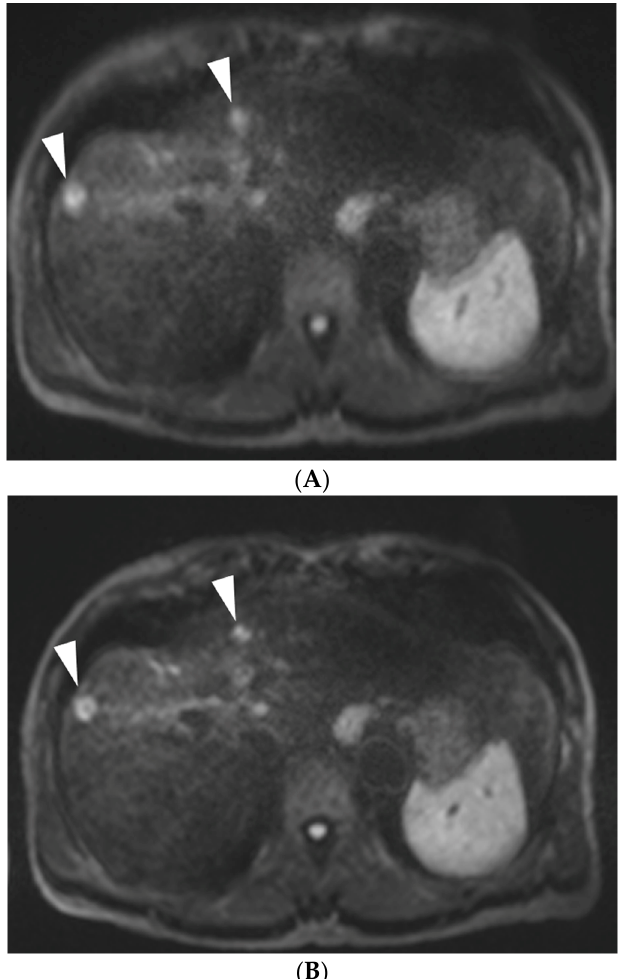
Figure 4. A 57-year-old man with hepatocellular carcinomas who underwent DWI. ( A ) Axial c-DWI (b = 800 s/mm 2 ) and ( B ) axial moco-DWI ((b = 800 s/mm 2 ). The conspicuity of the two hepatocellular carcinoma nodules (arrowheads) is better in moco-DWI ( B ) than in c-DWI ( A ). Table 3. Comparison of ADC measurement in liver parenchyma between c-DWI and moco-DWI. Post Hoc